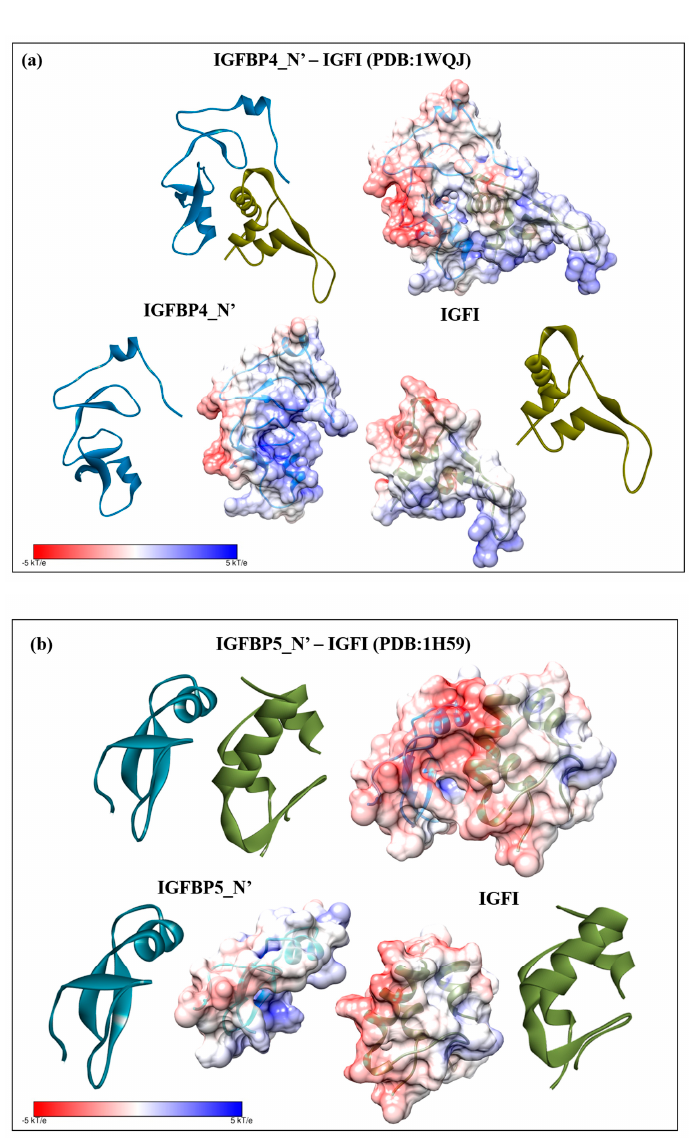
Figure 9. Electrostatic potential surface in vertebrates: ( a ) the bound complex and individual binding 1 partners of human IGFBP4_N’-IGFI (PDB: 1WQJ); and ( b ) human IGFBP5_N’-IGFI (PDB: 1H59). In both cases the IGFBP_N’ is coloured in blue and the IGFI in green. Surfaces are colored by potential on the solvent accessible surface on a scale of − kT/e (red) to +kT/e (blue), as indicated by the scale